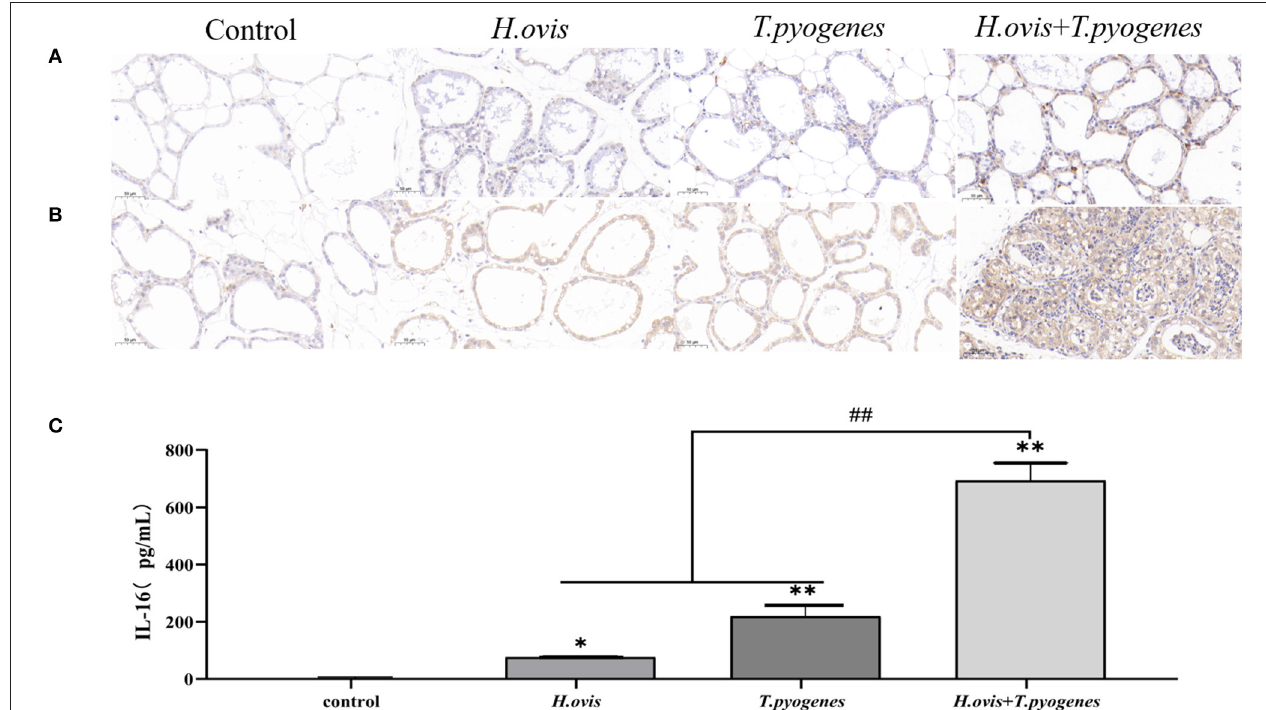
FIGURE 5 | Immunohistochemical (IHC) detection of IL-1 β and TNF- α in murine mammary glands and enzyme linked immunosorbent assay (ELISA) detection of IL-16 in murine serum after intramammary inoculation with Helcococcus ovis , Trueperella pyogenes , Helcococcus ovis , and Trueperella pyogenes. (A) IHC detection of IL-1 β in murine mammary glands challenged with Helcococcus ovis , Trueperella pyogenes , Helcococcus ovis , and Trueperella pyogenes . (B) IHC detection of TNF- α in murine mammary glands challenged with Helcococcus ovis , Trueperella pyogenes , Helcococcus ovis , and Trueperella pyogenes . (C) ELISA detection of IL-16 in murine serum challenged with Helcococcus ovis , Trueperella pyogenes , Helcococcus ovis , and Trueperella pyogenes . Data are mean ± SD of three independent experiments. * P < 0.05, ** and ## P <